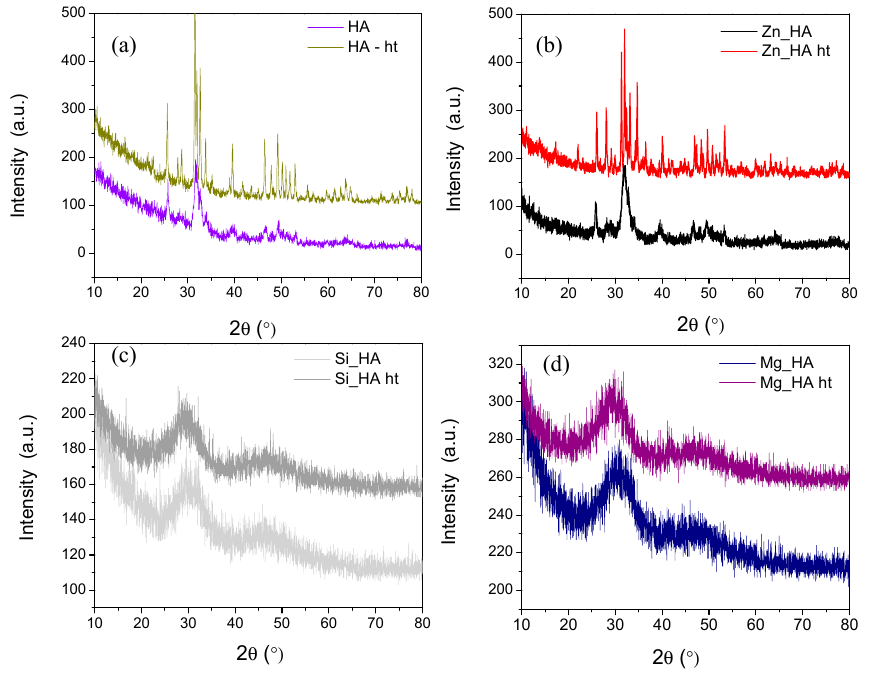
Figure 3. XRD spectra of as-deposited and heat-treated (ht) coatings. ( a ) HA; ( b ) Zn–HA; ( c ) Si–HA; ( d ) Mg–HA.